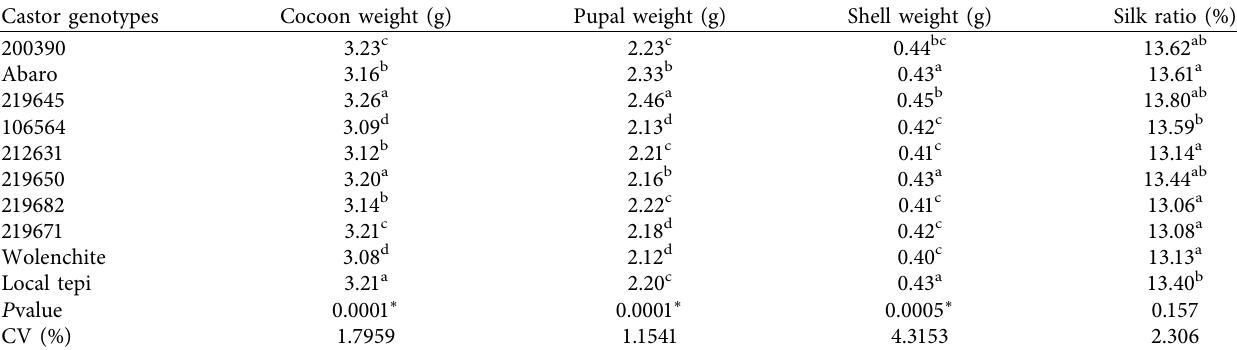
Table 4: Effect of different castor genotypes on cocoon, pupal and shell weight, and silk ratio. Castor